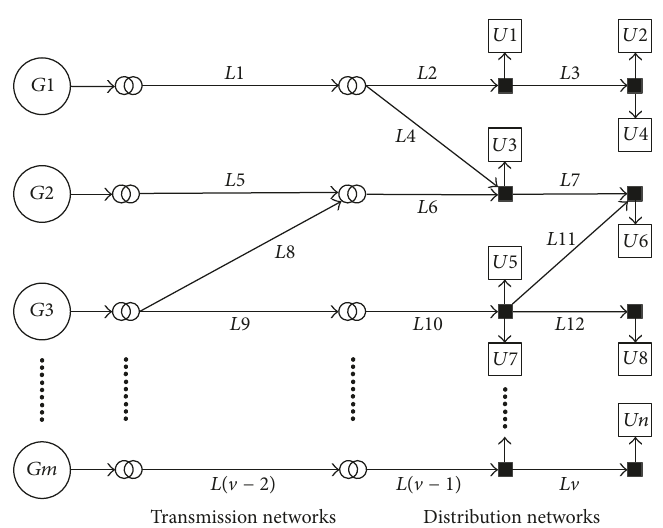
Figure 1: Topology of the smart grid. Note that 𝑈 𝑛 is the 𝑛 th consumers